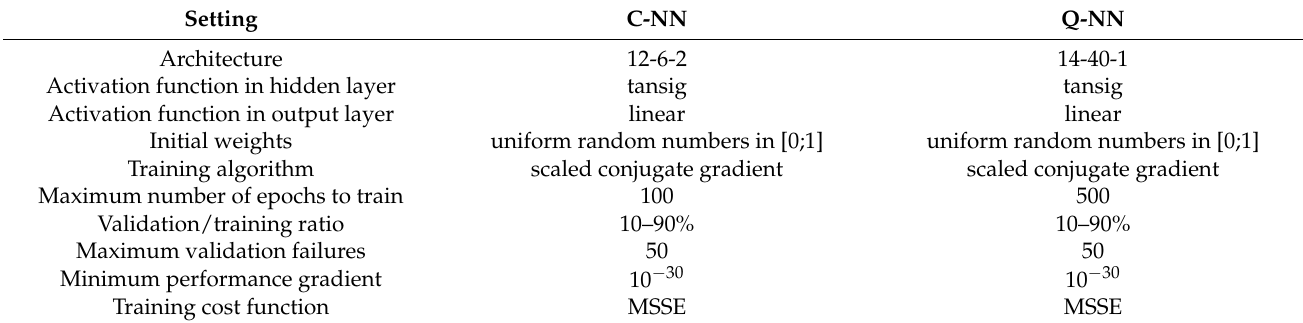
Table 7. AI-VIRL C-NN and Q-NN settings.